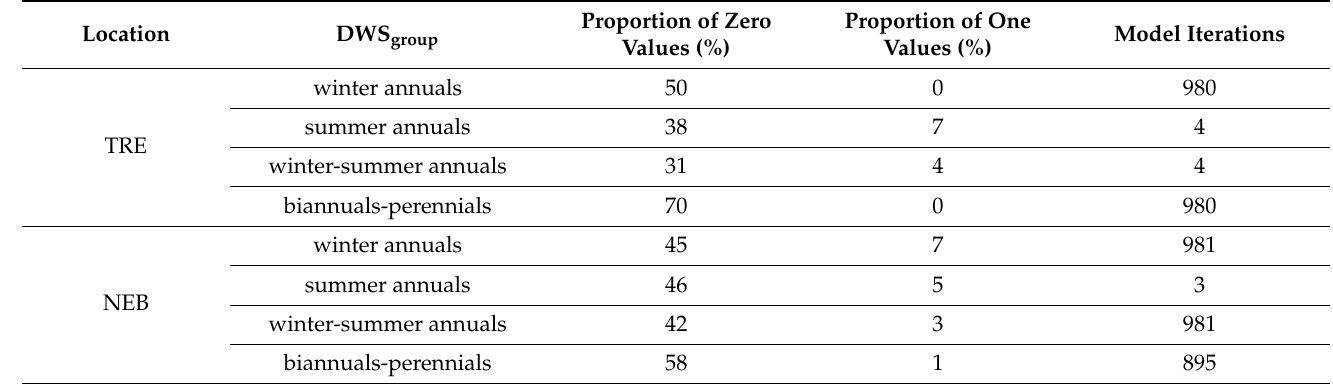
Table A2. Proportion of zero and one values of the raw datasets of each dominant weed species group (DWS group ) at each location and the iterations of the quasibinomial models. (TRE = Trenthorst, NEB =